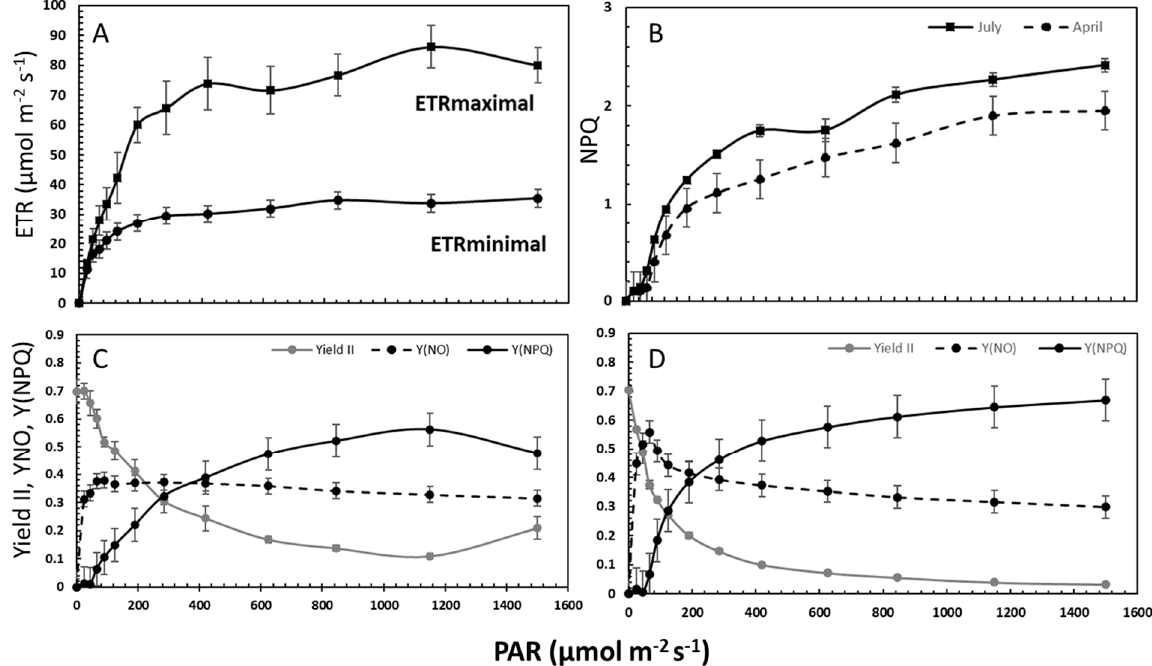
Figure 4. ( A ) Electron transport rate curve with maximal values in April and Electron transport rate (ETR) curve with minimal values in July along the seasonal time, ( B ) Non-Photochemical quenching (NPQ) curve vs irradiance with maximal values in July and NPQ curve with minimal values in April along the seasonal time, ( C ) Yield II, Y(NO) and Y(NPQ) curves in April with maximal values, and ( D ) Yield II, Y(NO) and Y(NPQ) curves in July with minimal values in L. spicata measured at Cochoa Beach, Viña del Mar, Chile, between autumn and summertime.